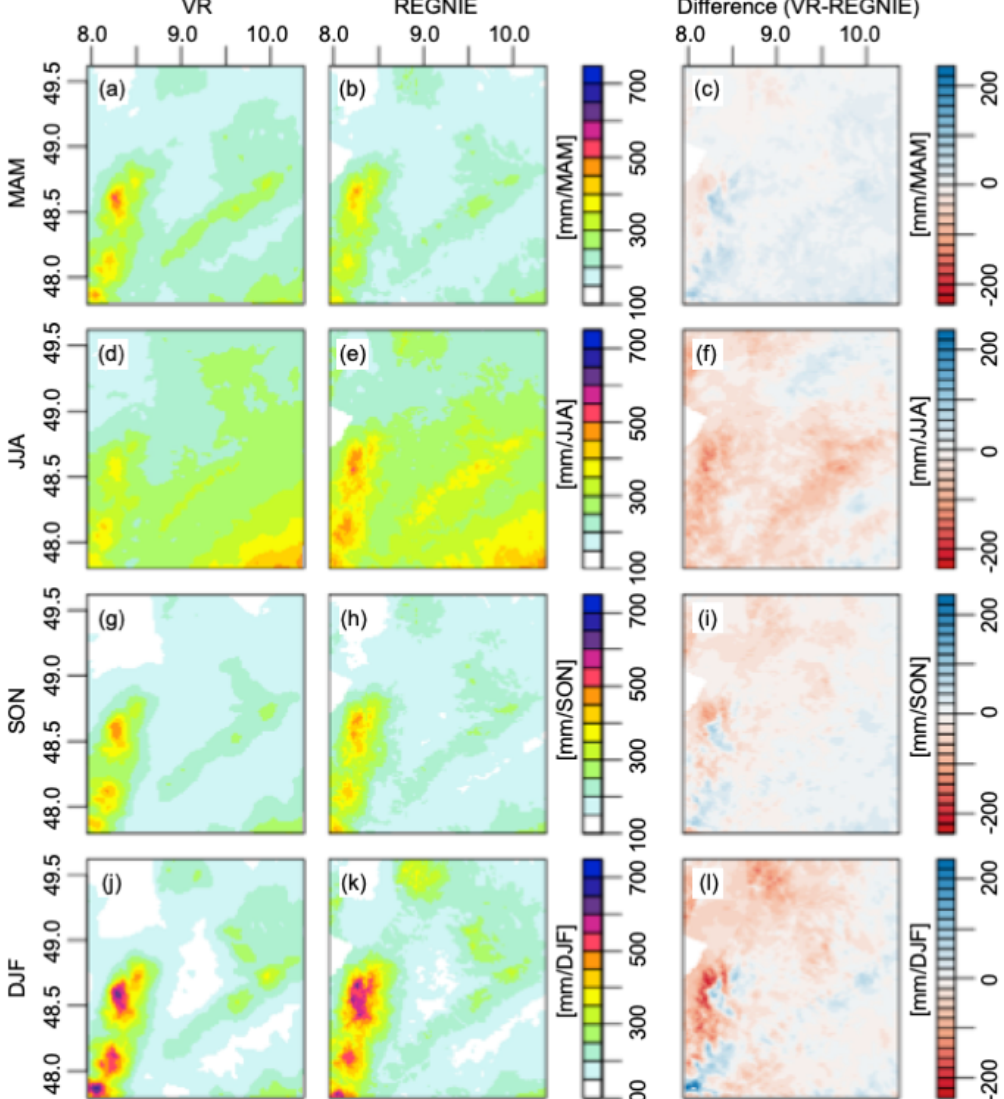
Figure 4. Mean seasonal precipitation over the Neckar catchment between 2007–2013 in the simulated reality (VR, left column) compared to the REGNIE dataset (middle column). The difference between VR and REGNIE is shown in the right column. Panels (a) – (c) show the comparison for spring (March–May); (d) – (f) for summer (June–August); (g) – (i) for fall (September–November); and (j) – (l) for winter